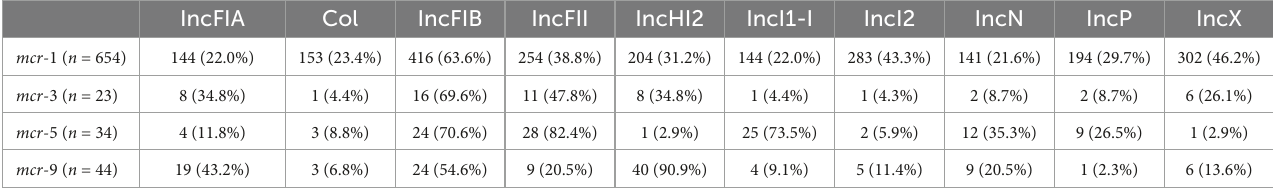
TABLE 2 Plasmids and their distributions among different mcr genes.